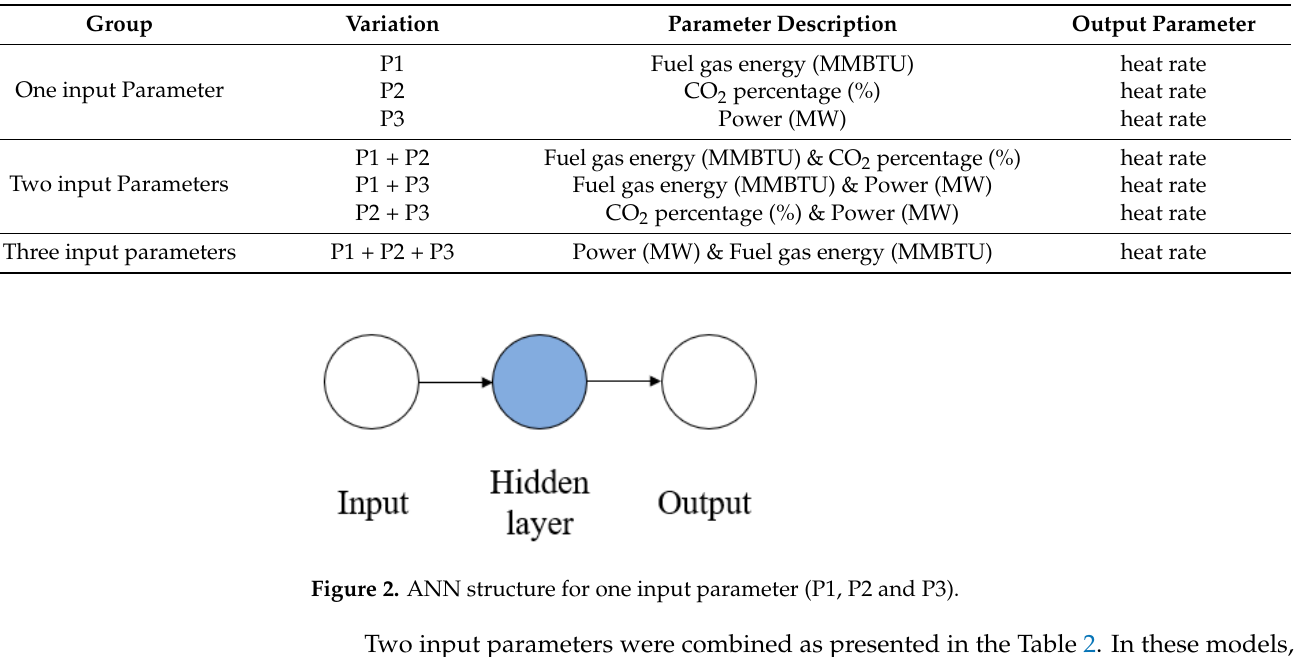
Figure 3. ANN structure for two input parameters (P1 + P2, P1 + P3 and P2 + P3). Figure 4. ANN structure for three input parameters (P1 + P2 + P3). The output parameter for all models was the plant heat rate, since the plant heat rate was usually used in a contractual agreement to judge whether the power plant was oper- ated efficiently or not. Each model used 10,000 epoch iterations and 1000 validation checks. Data used for training was 50%, while 25% was used for validation and the other 25% used for the test.